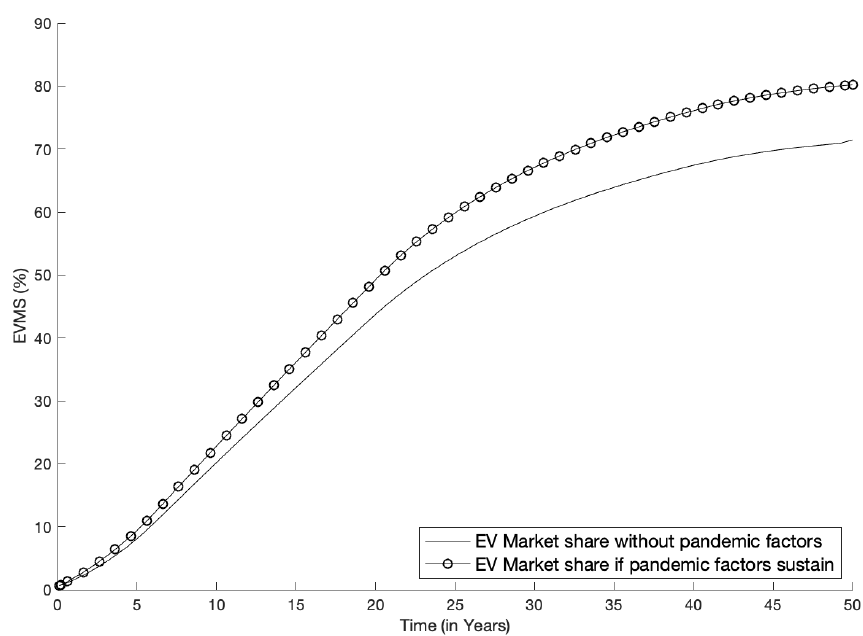
Figure 6. EVMS projections based on pandemic